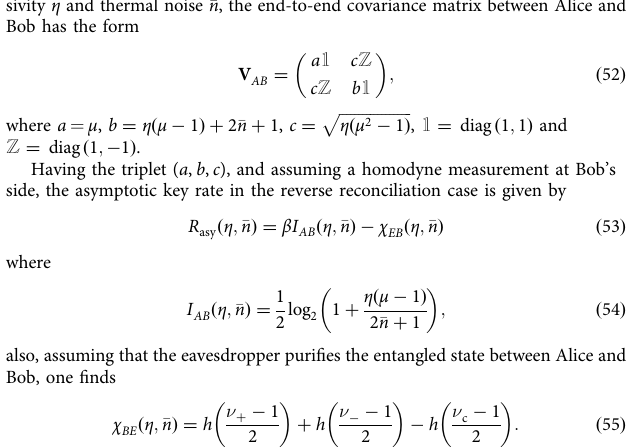
ffiffiffiffiffiffiffiffiffiffiffiffiffiffiffiffiffiffiffiffiffiffiffiffiffiffiffiffi p ð a þ b Þ 2 (cid:3) 4 c 2